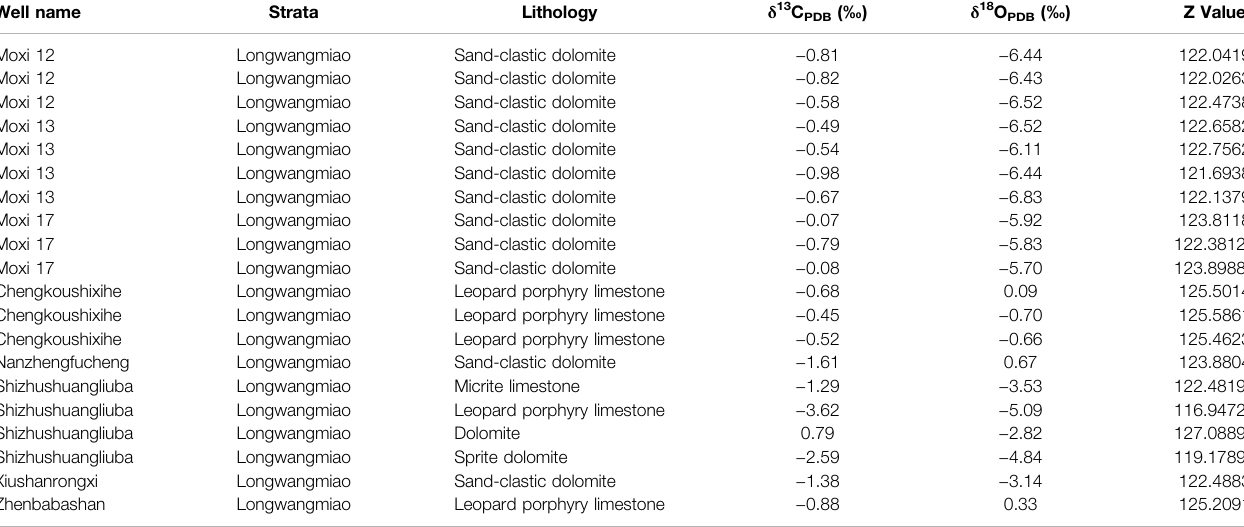
TABLE 3 | Dolomite carbon and oxygen isotope distribution table and calculated Z value of Longwangmiao Formation in Sichuan Basin.